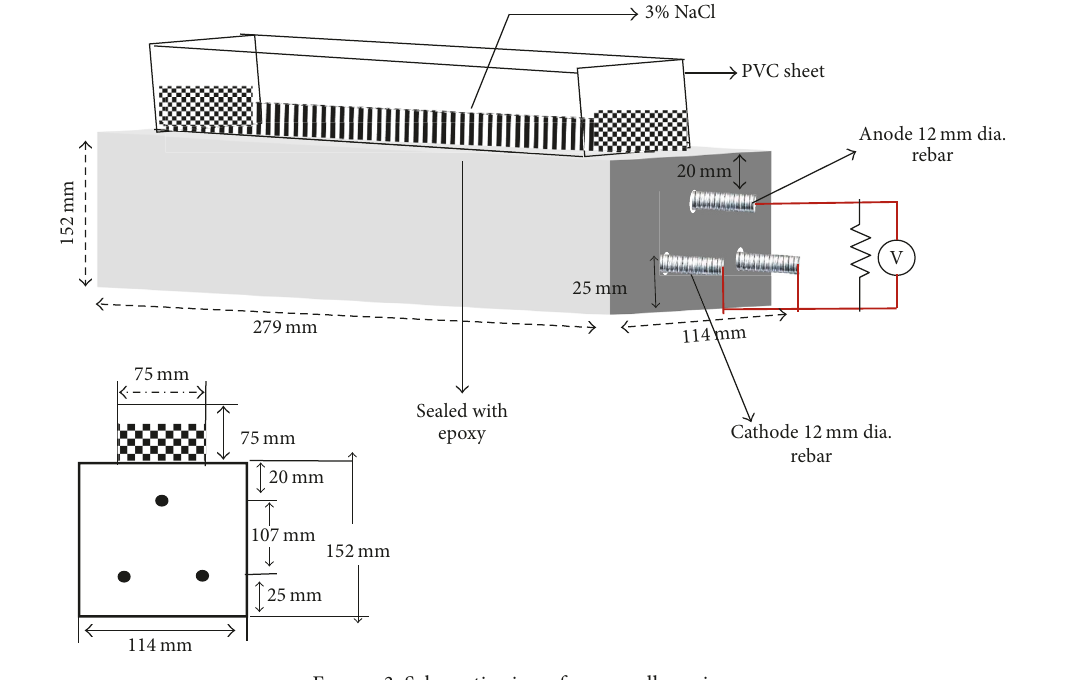
Figure 3: Schematic view of macrocell specimen. Table 3: Permeability parameters for OPC, PPC, and PSC M30 and M40 grade concrete